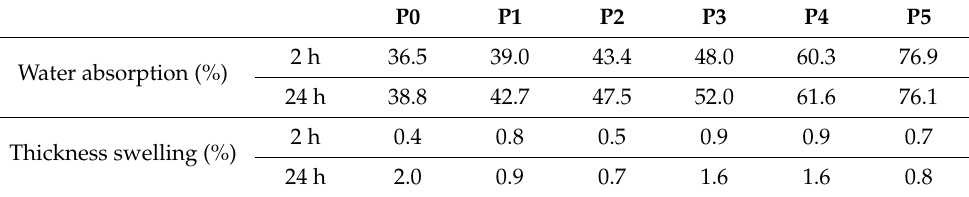
Figure 6. Water absorption and thickness swelling of WCAP recorded as a function of the WA content. Table 6. Average water absorption and swelling of WCAP as a function of the WA content.